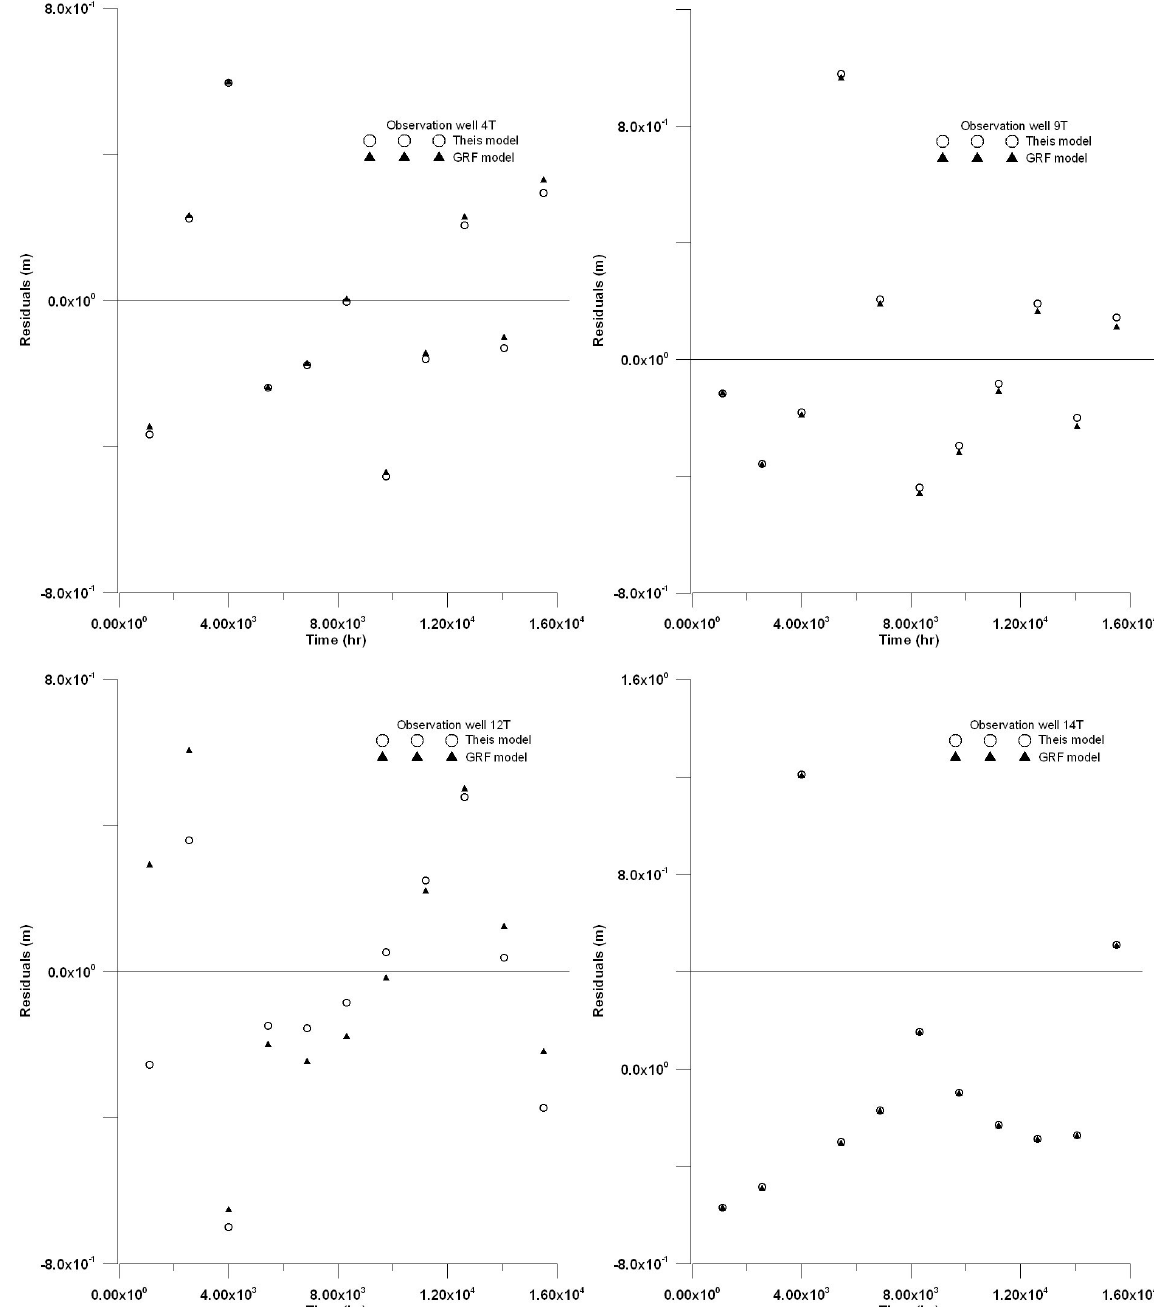
Fig. 6. The residuals for different models: Observation well (a) 4T; (b) 9T; (c) 12T; and (d)